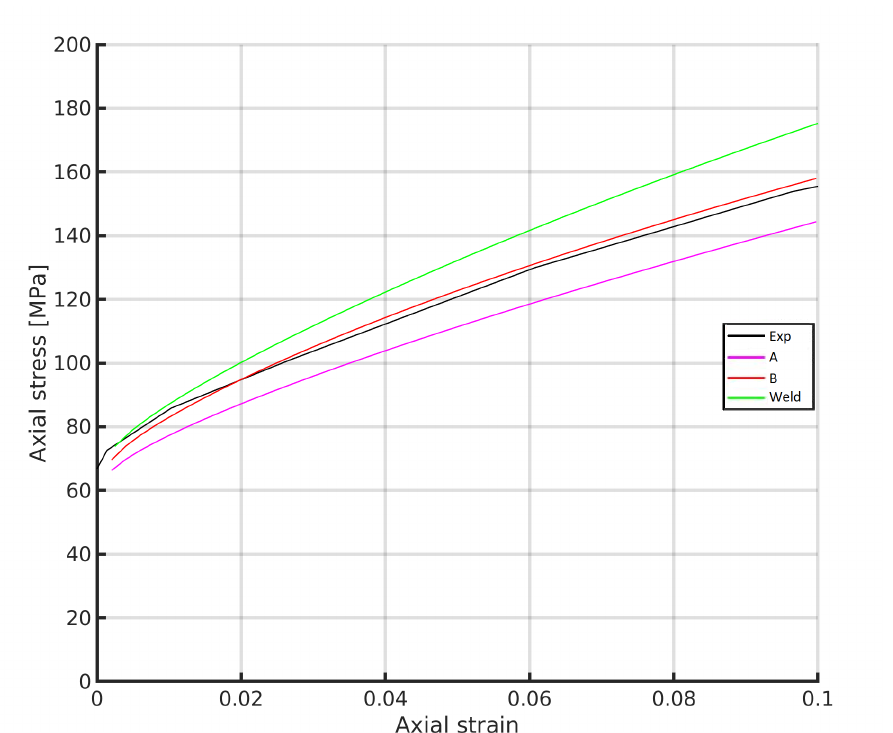
Figure 3. Simulated stress–strain curves for materials A, B and C and experimentally measured